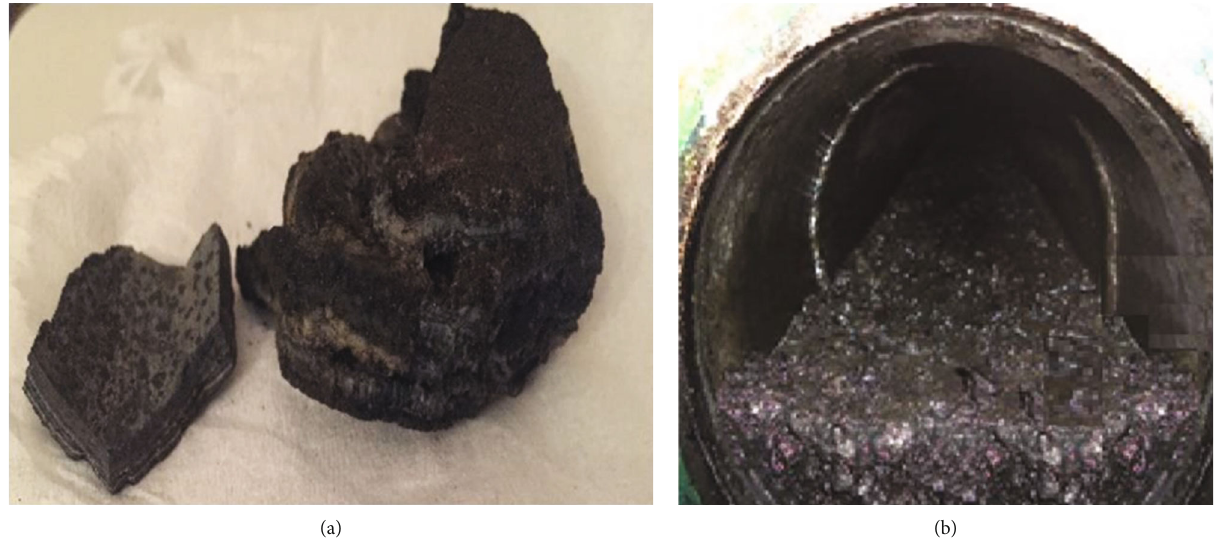
Figure 2: Barium sulfate samples from the fi eld. (a) Collected from a platform. (b) Collected from a transportation pipeline. Table 1: XRD results for the collected barium scale samples.